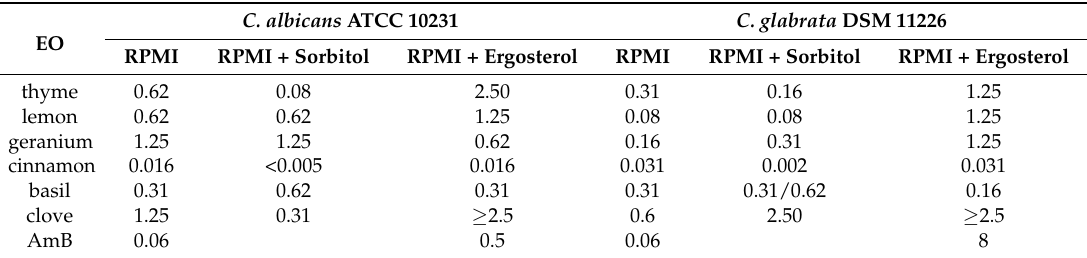
Table 5. MIC values of the tested oils in the presence and absence of sorbitol/ergosterol.